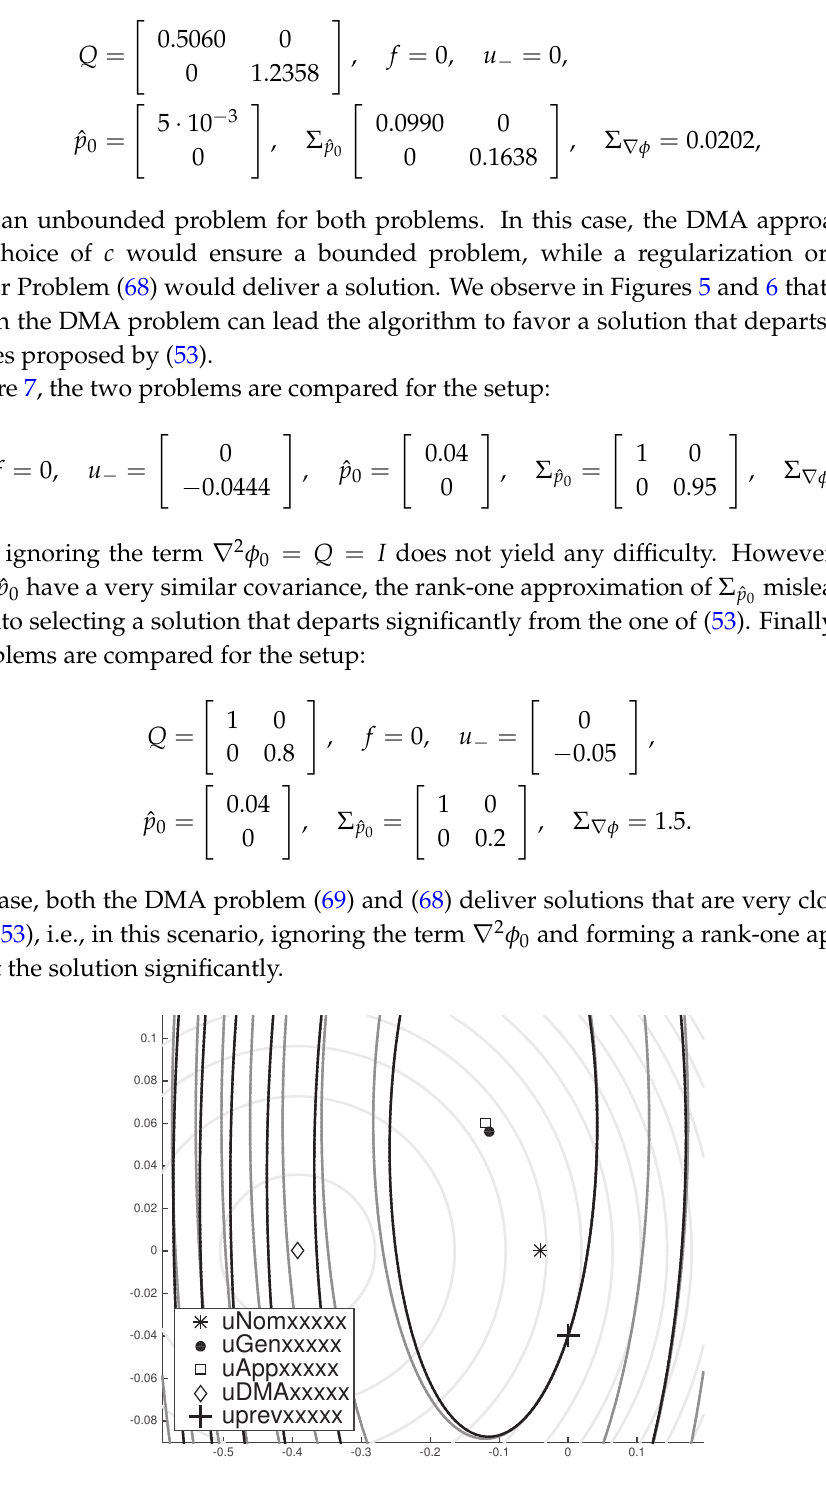
Figure 7. Illustration for Section 3.3, setup (71). The black lines report the level curves of the cost of Problem (67); the grey lines report the level curves of the cost of Problem (68); and the light grey lines report the level curves of the cost of Problem (69) with Q given by (63). In this example, the rank-one approximation for Q leads the DMA algorithm to propose a solution that is far from the one of